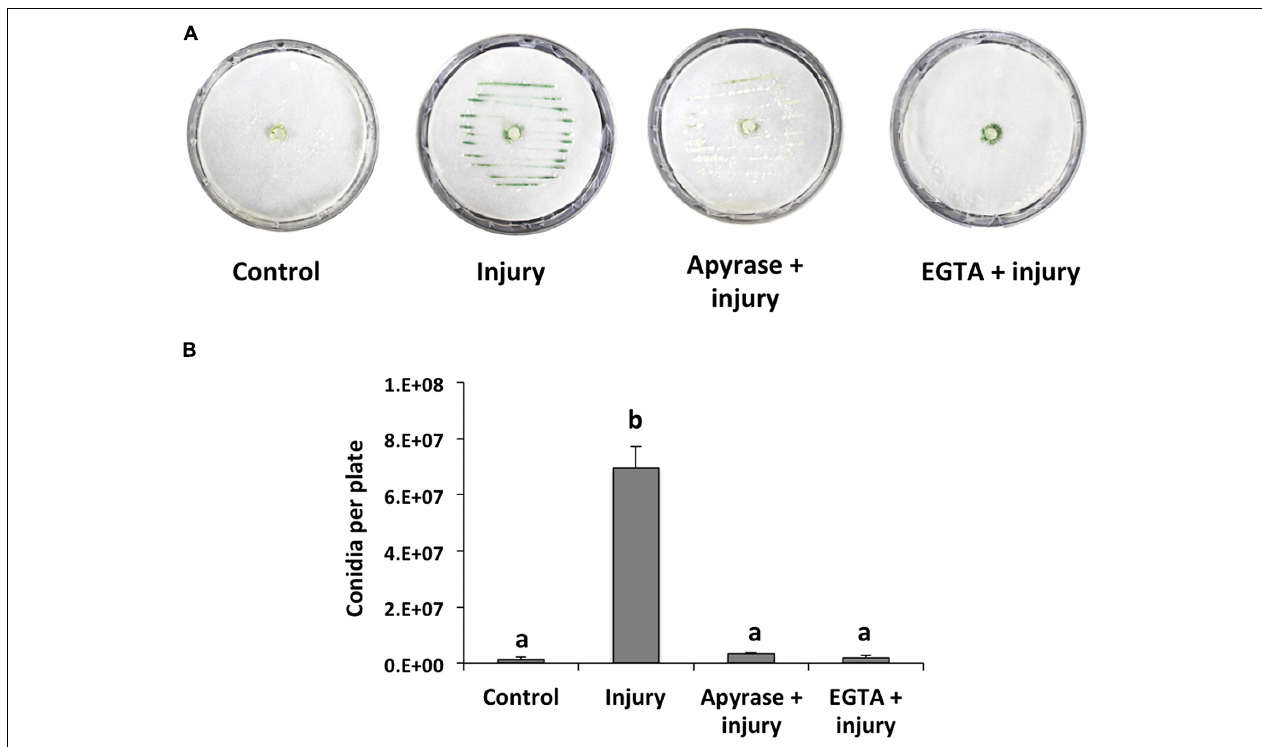
FIGURE 1 | Effect of EGTA and apyrase on injury-induced conidiation. (A) Colonies of the fungus were damaged using a scalpel to induce conidiation (visualized as green lines). Prior to damage, apyrase or 15mM EGTA were added. Photographs were taken 48 hours after injury. An